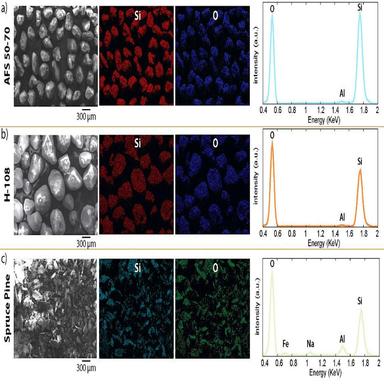
Morphological and compositional analysis of (a) AFS 50–70, (b) H-108, (c) Spruce Pine sands.